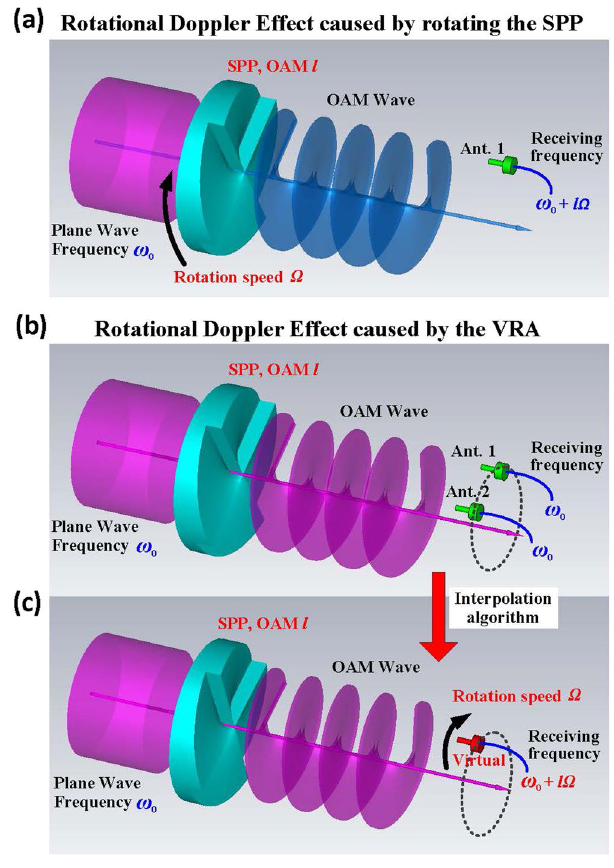
Figure 1. Doppler Effect caused by the VRA. ( a ) Detecting the OAM mode by rotating the SPP at the transmitter. Rotating the SPP of mode l with speed Ω , a frequency shift lΩ can be detected by a fixed receiving antenna. ( b ) Receiving OAM wave using two fixed antennas. Two transverse-deployed antennas are used to receive the OAM wave generated by a fixed SPP. The frequency detected by each antenna is the same as that of the transmitter. No frequency shift arises. ( c ) Receiving OAM wave using the VRA. By weighting and adding the two received signals, an interpolated signal is generated. The phase of the interpolated signal gradually varies between one antenna and the other. This performs similarly to a virtual antenna, rotating from one antenna to the other. Due to the rotational Doppler Effect, a frequency shift can be detected in the interpolated